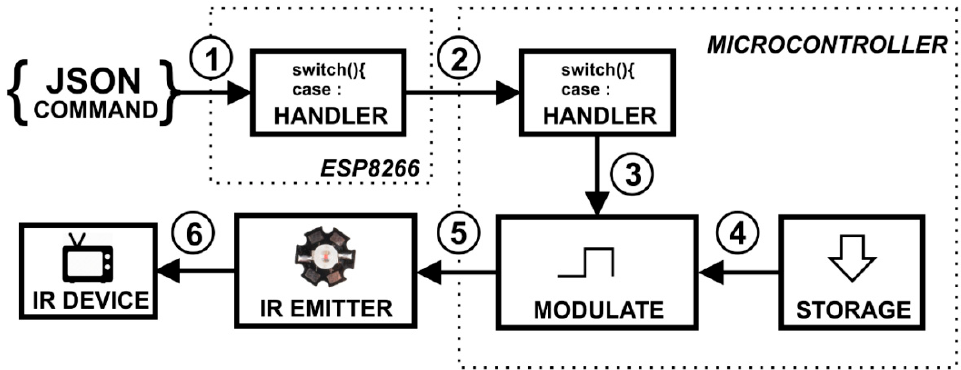
Figure 6. Circuit of IR emission commands previously stored.